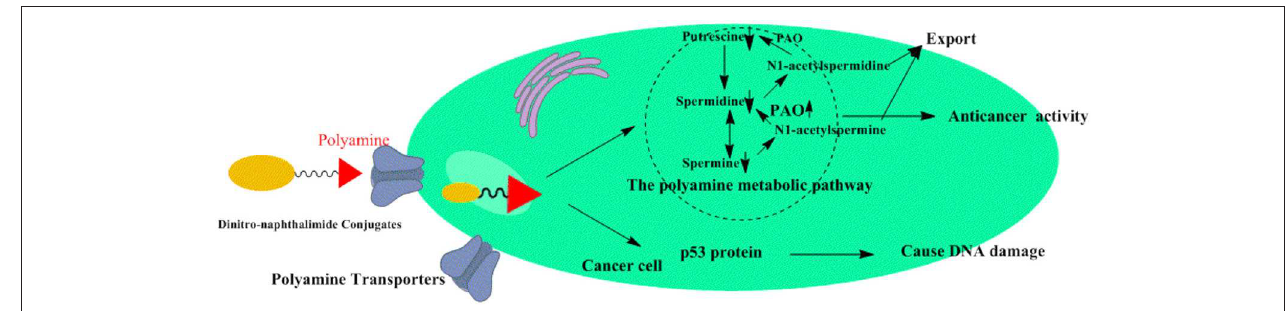
FIGURE 9 | Proposed mechanism of action for dinitro-naphthalimide conjugates 5c .